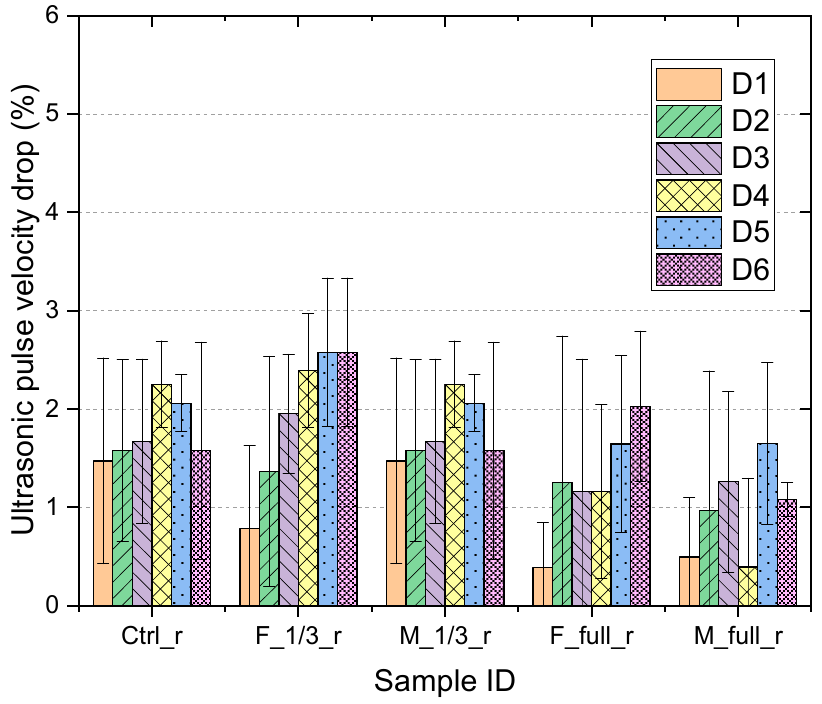
Figure 8. UPV of beams at different damage degree 𝐷 (cid:3036) ( i = 1,…,6).